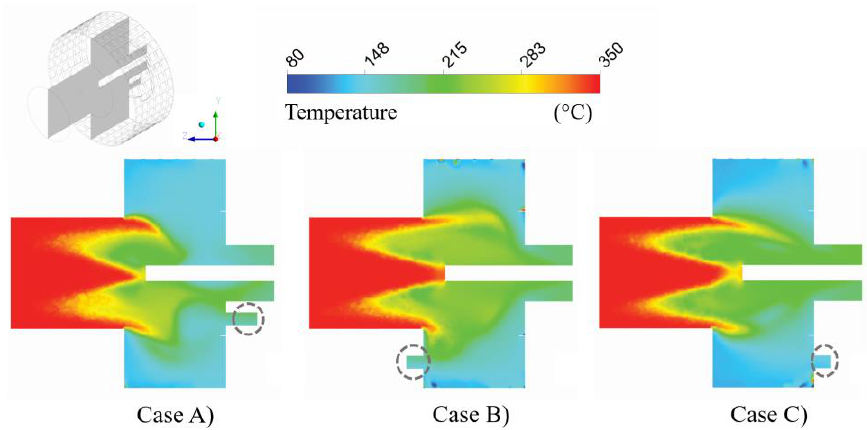
Figure 5. Gas temperature distribution with droplet injection at the Y-Z plane.